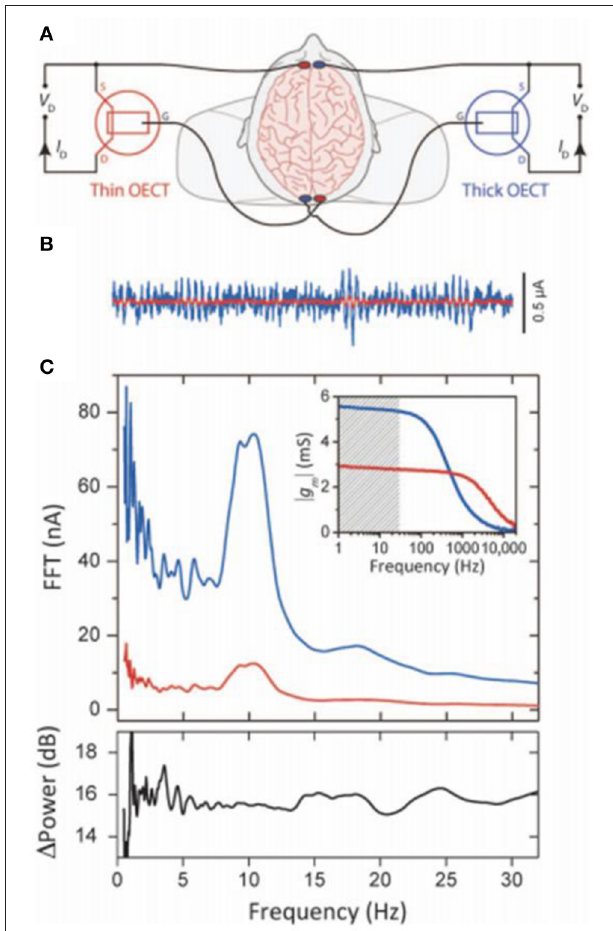
FIGURE 10 | High-transconductance OECTs enhanced EEG recordings. (A) Schematic wiring of simultaneously recording human EEG signals by two OECTs. (B) The rhythm from a thin (red) and thick (blue) 6-s recordings of OECT. (C) Top: fast Fourier transform (FFT) of simultaneous 60s EEG recordings (inset: response of transconductance frequency, shaded band is the EEG-relevant frequencies). Bottom: the power enhancement recording from the thick compared to the thin device, showing the richer spectral content below the α band and using the thick device leading to the enhanced low-frequency signal (Rivnay et al., 2015a). Reproduced with permission (Rivnay et al., 2015a). Copyright © 2015 American Association for the Advancement of